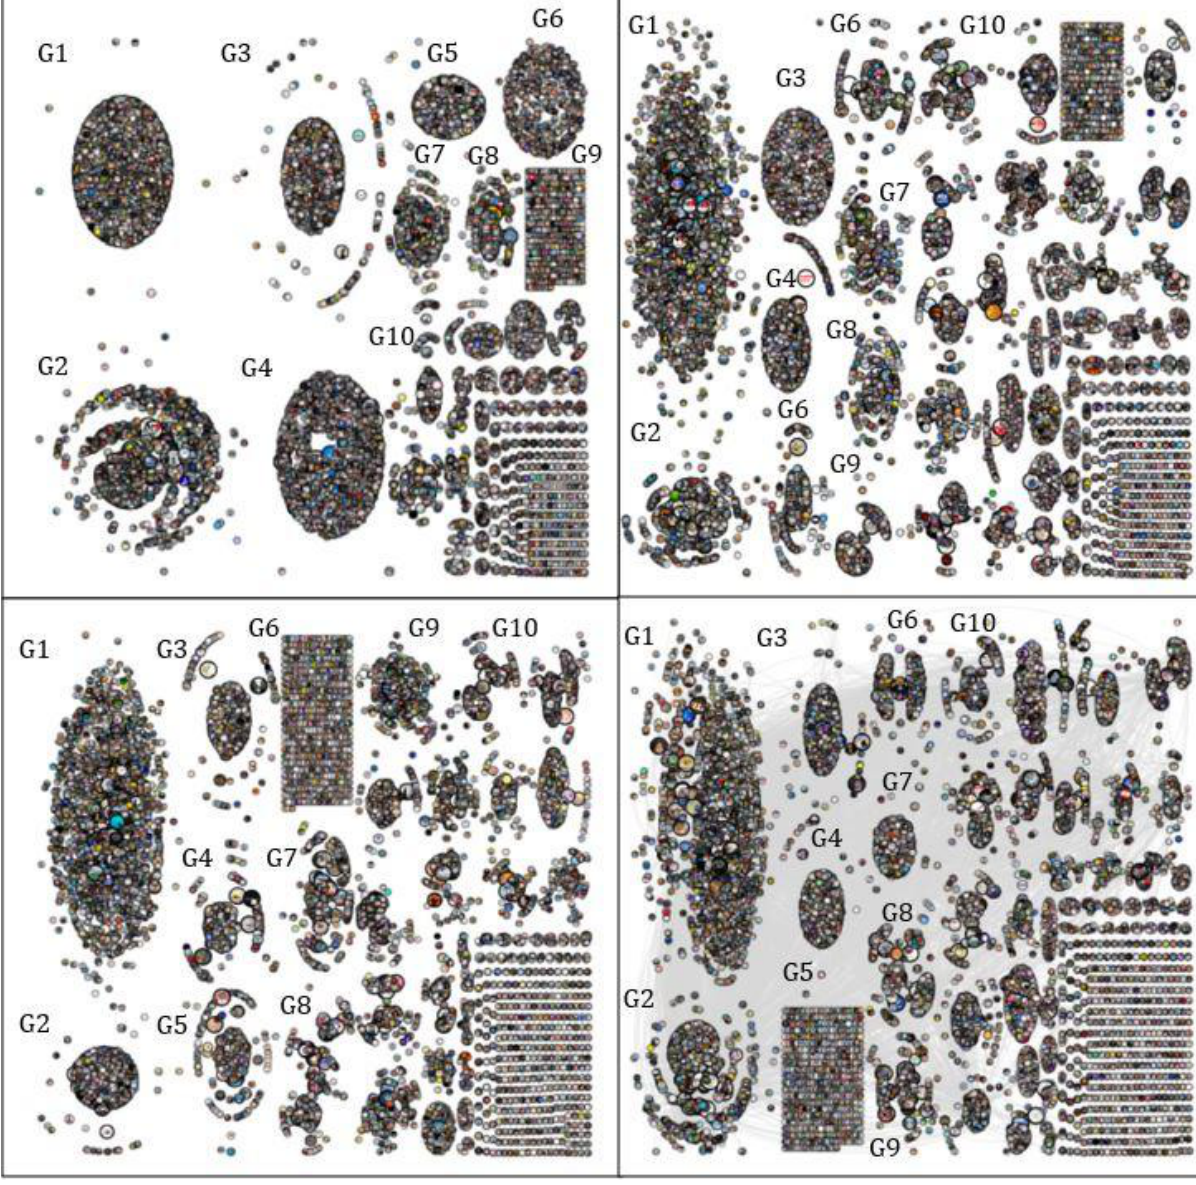
Table 1. Comparing user relationships across coronavirus disease networks.